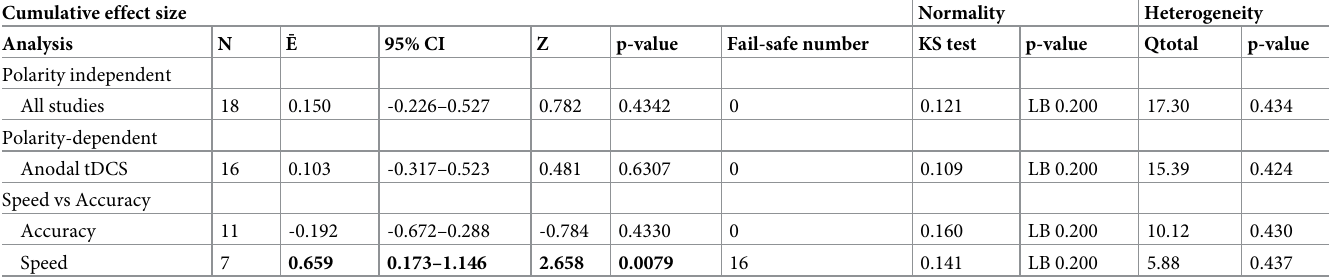
Table 4. Meta-analysis results for the effects of tDCS on working memory in ADHD